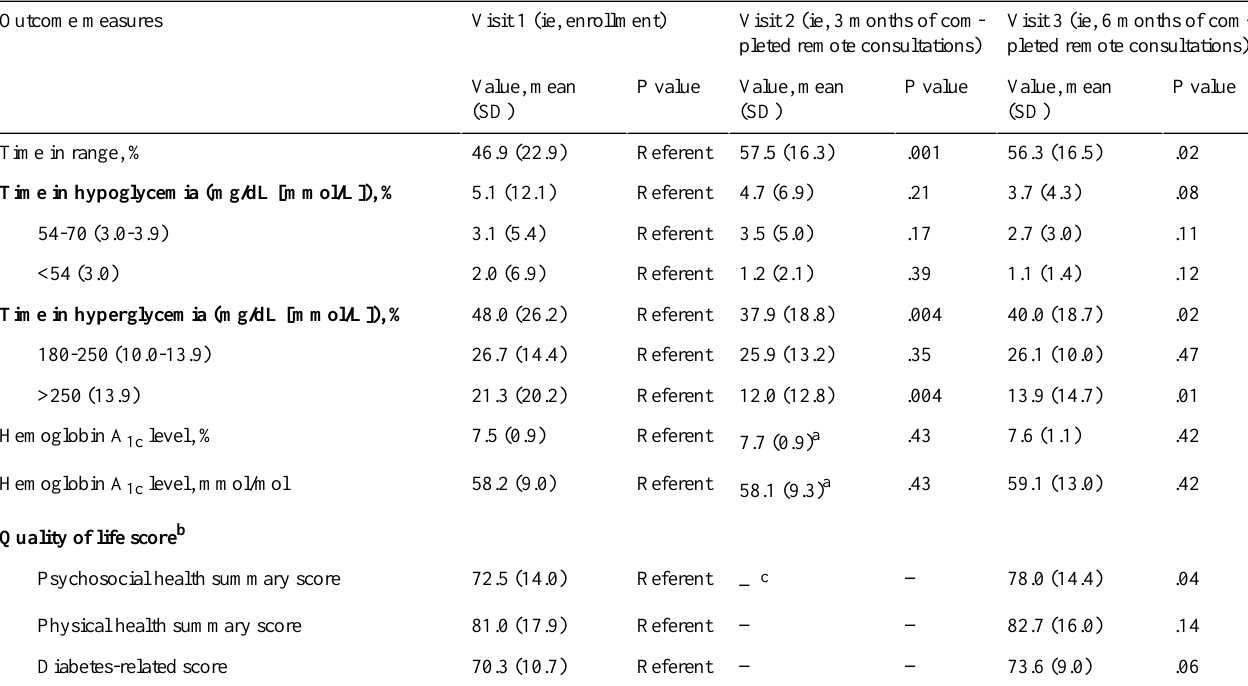
Table 3. Clinical and patient-reported outcomes before, during, and after 6 months of remote consultations. All significance levels for the visit 2 and visit 3 results were compared to those for visit